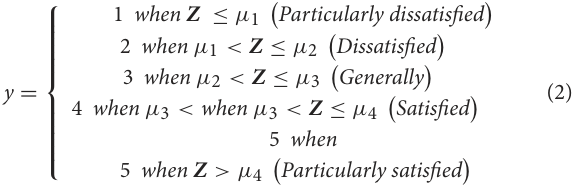
TABLE 3 Definitions of travel moods. Variable degree